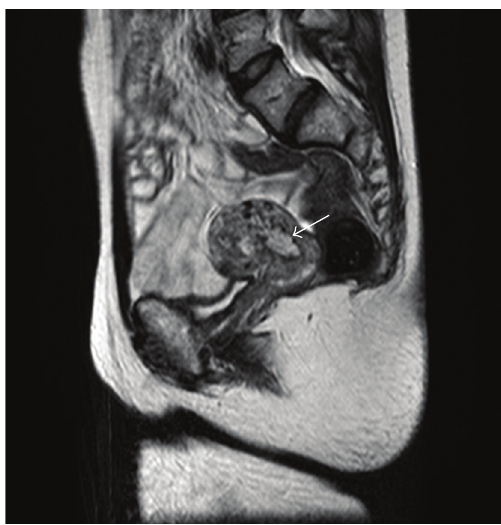
Figure 1: MRI at 21 weeks of gestation. Arrows show location of intra-abdominal bleeding.